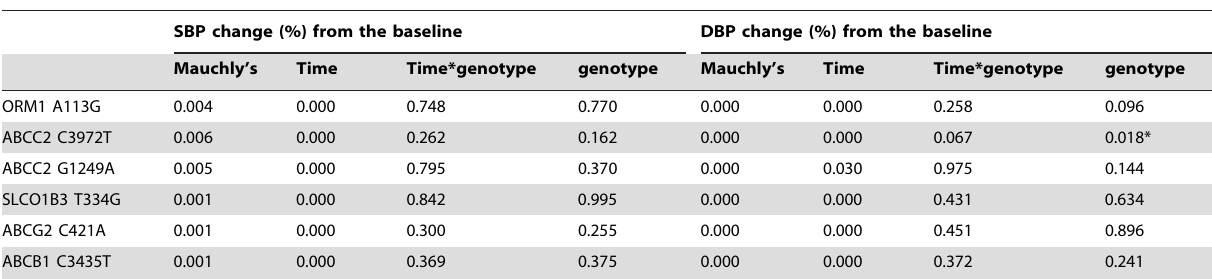
Table 5. The significance affected by time or genotypes on the BP change(%) from the baseline.